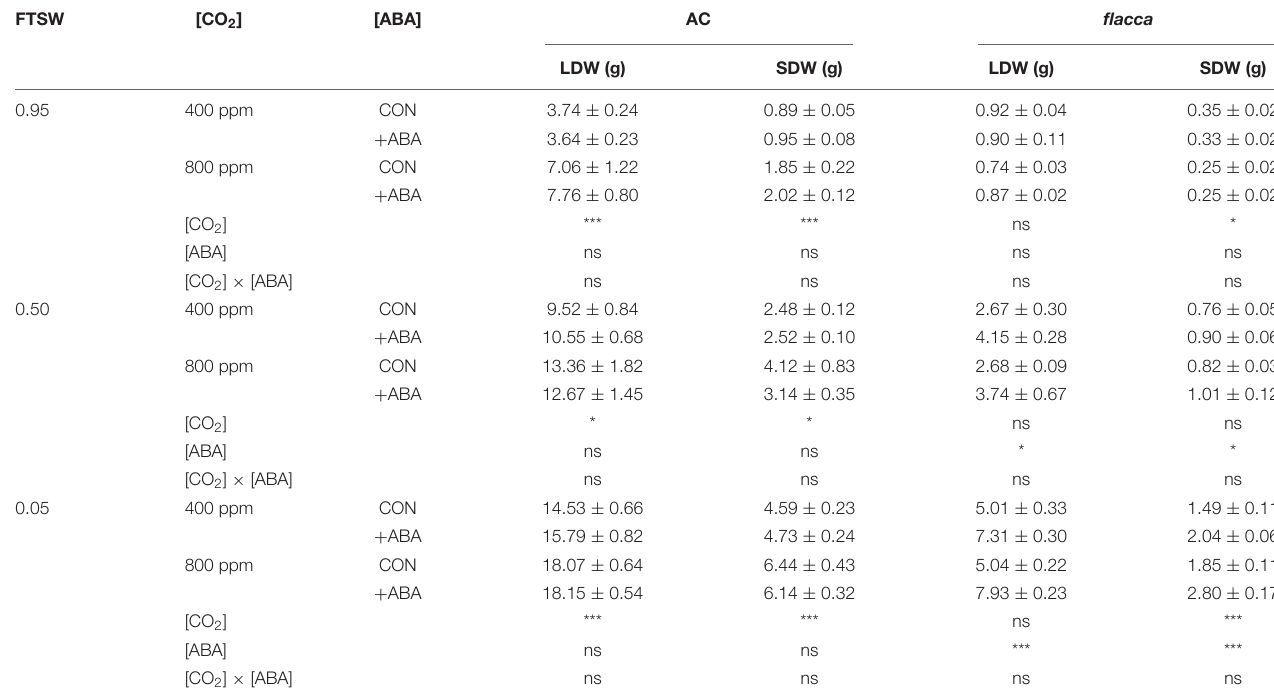
FTSW indicates the fraction of transpirable soil water. [CO 2 ] indicates [CO 2 ] level, [ABA] indicates without or with exogenous ABA application (expressed as CON/ + ABA). * and *** indicate the significant differences between [CO 2 ] levels or ABA treatments at p < 0.05, p < 0.001, respectively. ns denotes no significant difference. Values are means ± standard error of the means (S.E.) (n = 3–4).